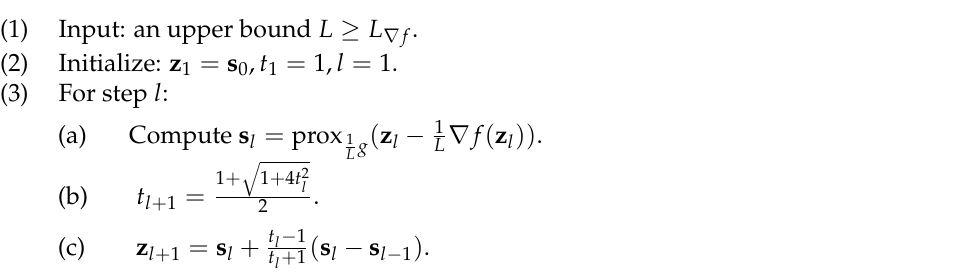
Algorithm 1 Fast Iterative Shrinkage-Thresholding